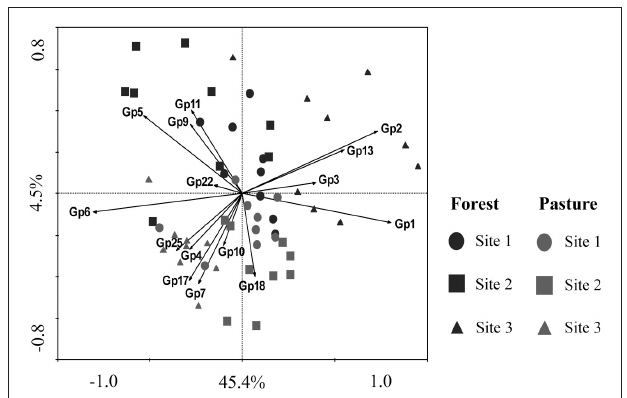
FIGURE 1 | Constrained ordination diagram for sample plots in the first two redundancy analysis (RDA) axes based on the soil chemical characteristics of the different sampling sites and their relationship with the relative abundance of Acidobacteria subgroups (1–7, 9–11, 13, 17, 18, 22, and 25). Each vector points to the direction of increase for a given Acidobacteria subgroup (Gp) and its length indicates the strength of the correlation between this variable and the ordination